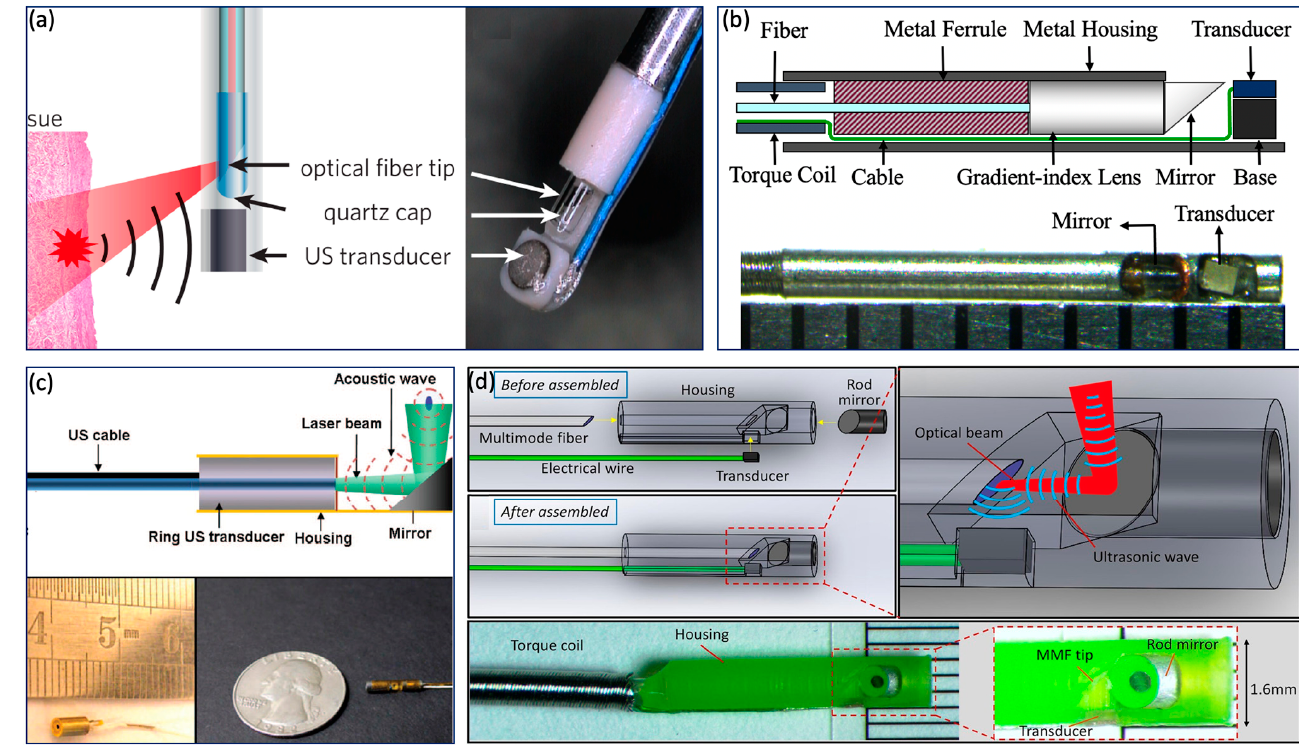
Figure 4. Intravascular imaging probe. ( a ) Sequential alignment and broad illumination. Adapted from [72]. ( b ) Sequential alignment and focusing illumination. Adapted from [22]. ( c ) Coaxial alignment and broad illumination. Adapted from [11]. ( d ) Coaxial alignment and broad illumination. Adapted from [70].